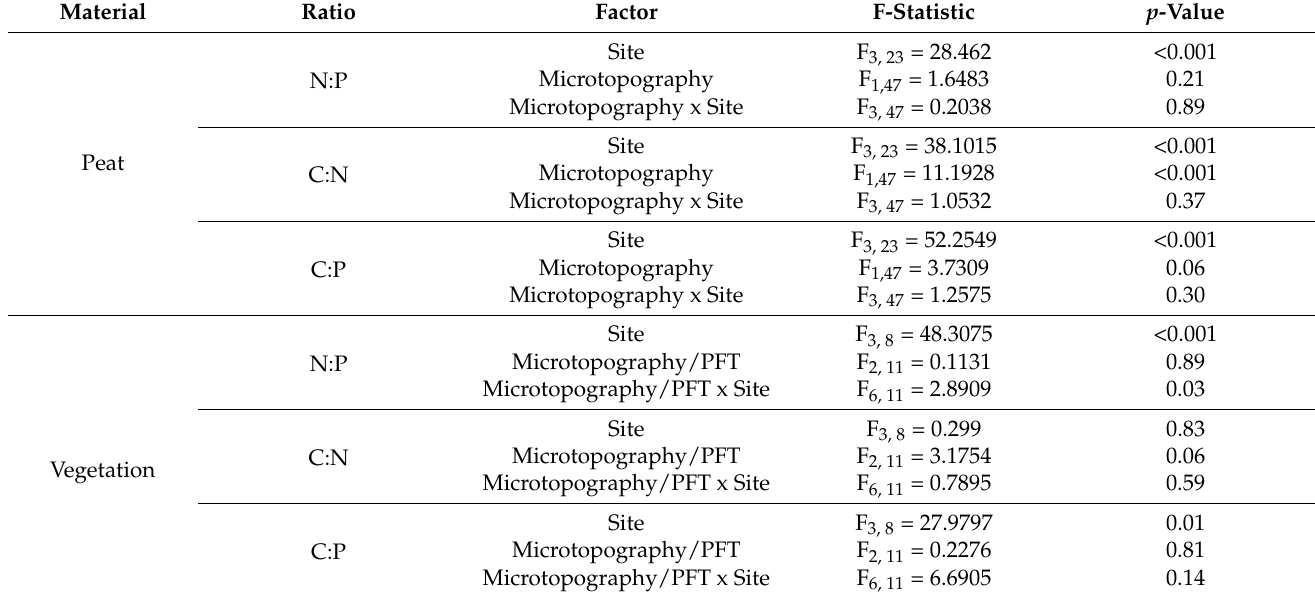
Table 3. Results from the linear mixed effect models for Stoichiometric ratios of peat and